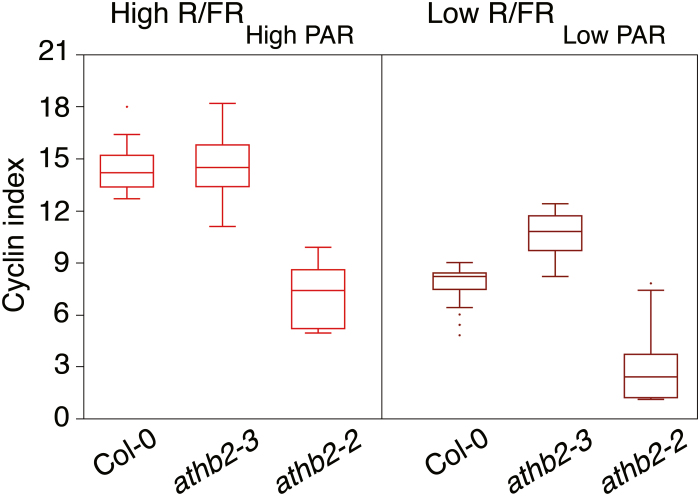
Loss- and gain-of-function mutations in ATHB2 affect the expression of the CYCB1;1:GUS marker during leaf development in shade. CYCB1;1:GUS, athb2-3 CYCB1;1:GUS, and athb2-2 CYCB1;1:GUS seedlings were grown in a light/dark cycle (16/8 h) in High R/FRHigh PAR for 8 d (High R/FRHigh PAR) or for 4 d in high R/FR and subsequently for 5.5 d in Low R/FRLow PAR (Low R/FRLow PAR). The box-and-whiskers plot presents the cyclin indices for the adaxial subepidermal layer in the proximal region of wild-type and mutant leaves with an area of ~0.35 mm2 under the two different light conditions. The box delimits the first and third quartiles; the solid line within the box represents the second quartile; bars indicate the upper and lower fence; dots represent outliers. First and second leaf area (mean ±SE), High R/FRHigh PAR: CYCB1;1:GUS, 0.35 ± 0.004 mm2; athb2-3 CYCB1;1:GUS, 0.35 ± 0.003 mm2; athb2-2 CYCB1;1:GUS, 0.35 ± 0.003 mm2. First and second leaf area (mean ±SE), Low R/FRLow PAR: CYCB1;1:GUS, 0.35 ± 0.004; athb2-3 CYCB1;1:GUS, 0.35 ± 0.003 mm2; athb2-2 CYCB1;1:GUS, 0.35 ± 0.004 mm2.